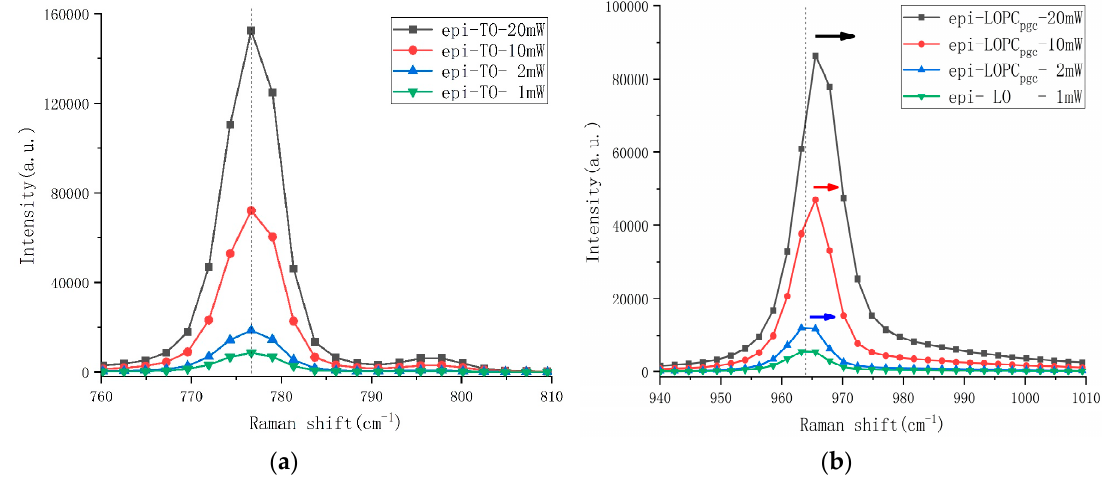
Figure 6. Raman spectra of the epi sample with exciting line at 325 nm, ( a ) TO modes, ( b ) LOPC pgc modes, using different laser power (as indicated in the legend).